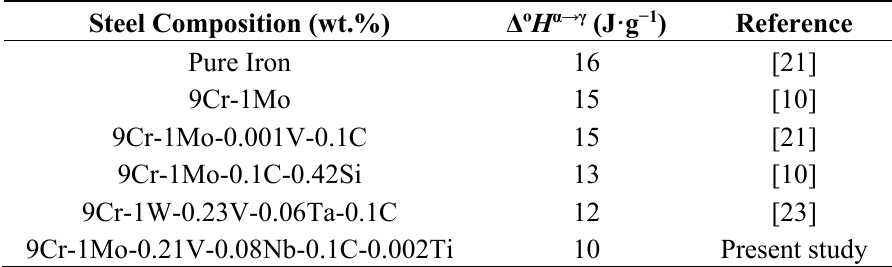
Table 3. Comparison of enthalpy associated with α→γ phase change. Steel Composition